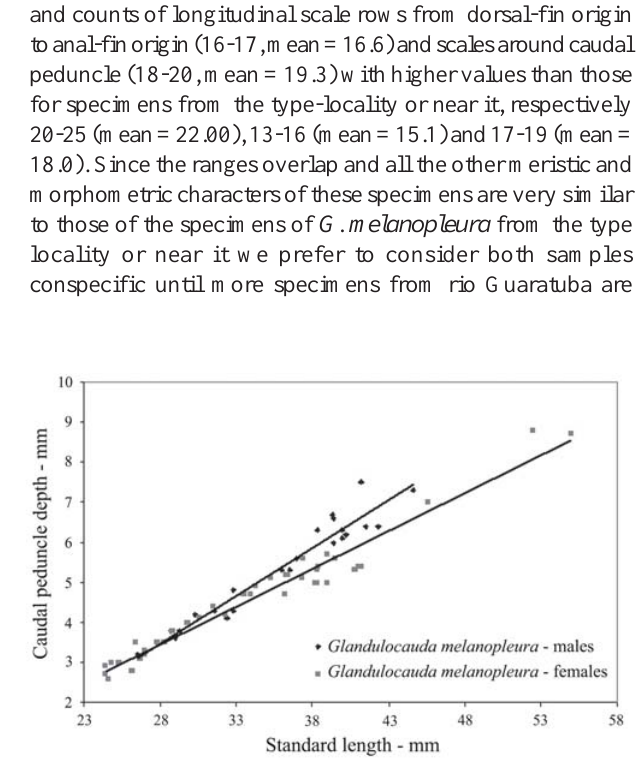
Fig. 19. Glandulocauda melanopleura , caudal peduncle depth as function of SL by sex. Plots illustrate difference between sexes in this feature. See text under sexual dimorphism for further